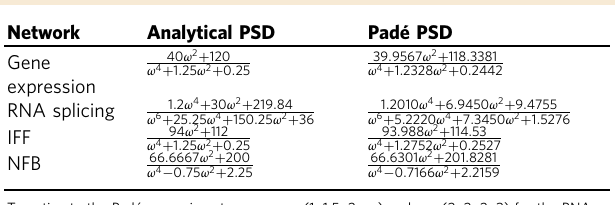
Table 1 Expressions for PSDs estimated analytically and with the Padé PSD